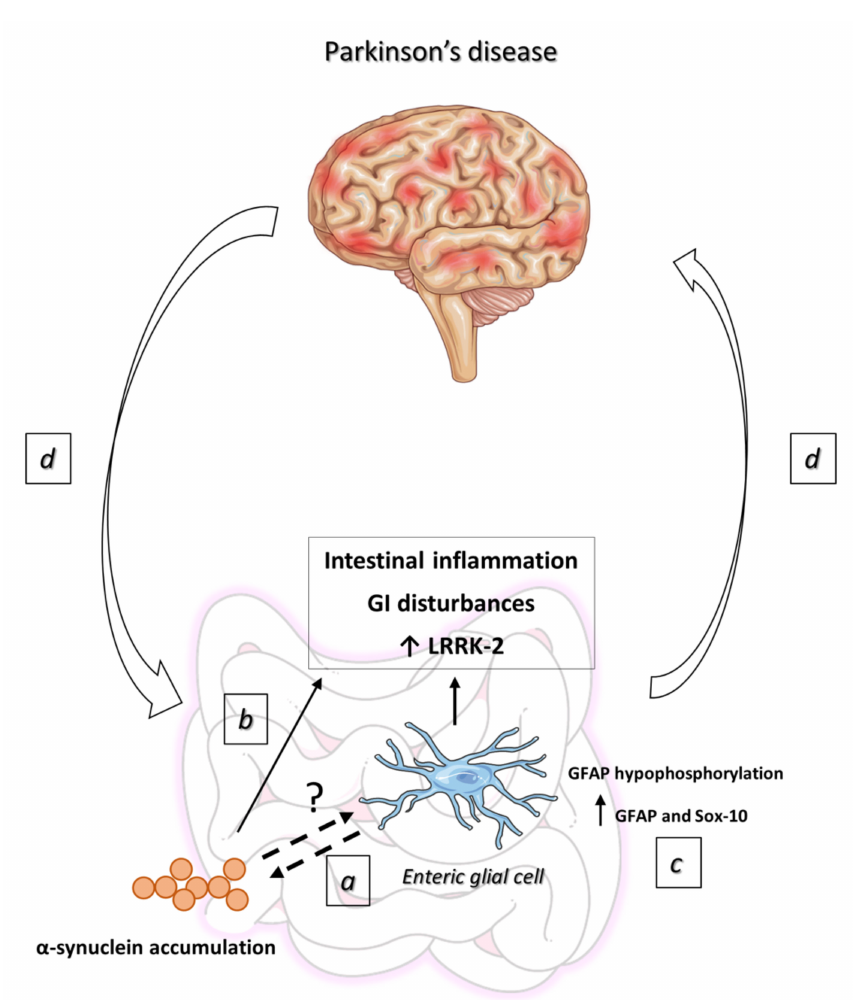
Figure 4. Schematic representation of the role of EGCs in the pathophysiology of PD. ( a ) Enteric α -synuclein accumulation in concomitance with alterations of EGC functions are distinctive pathological features of PD. In this setting, a “pathological loop” between glial activation by the aggregated α -synuclein and the induction of α -synuclein misfolding by the activated enteric glia has been reported, highlighting the involvement of EGCs in the etiology of PD. ( b ) The presence of misfolded α -synuclein is associated with the occurrence of GI disturbances and an increased expression of proteins linked to PD, such as LRRK-2. ( c ) The increase in Soxo-10 / GFAP-positive EGCs, besides triggering intestinal motor dysfunctions, contributes to shape enteric immune / inflammatory responses. ( d ) Enteric immune / inflammatory events could trigger neuroinflammation and subsequent neurodegeneration in the CNS through gut–brain ascending pathways. In this setting, central neuroinflammation could, in turn, contribute to exacerbate enteric neuro-inflammatory conditions, through brain–gut descending pathways, triggering a sort of positive loop that could drive the chronicization of the ongoing inflammatory